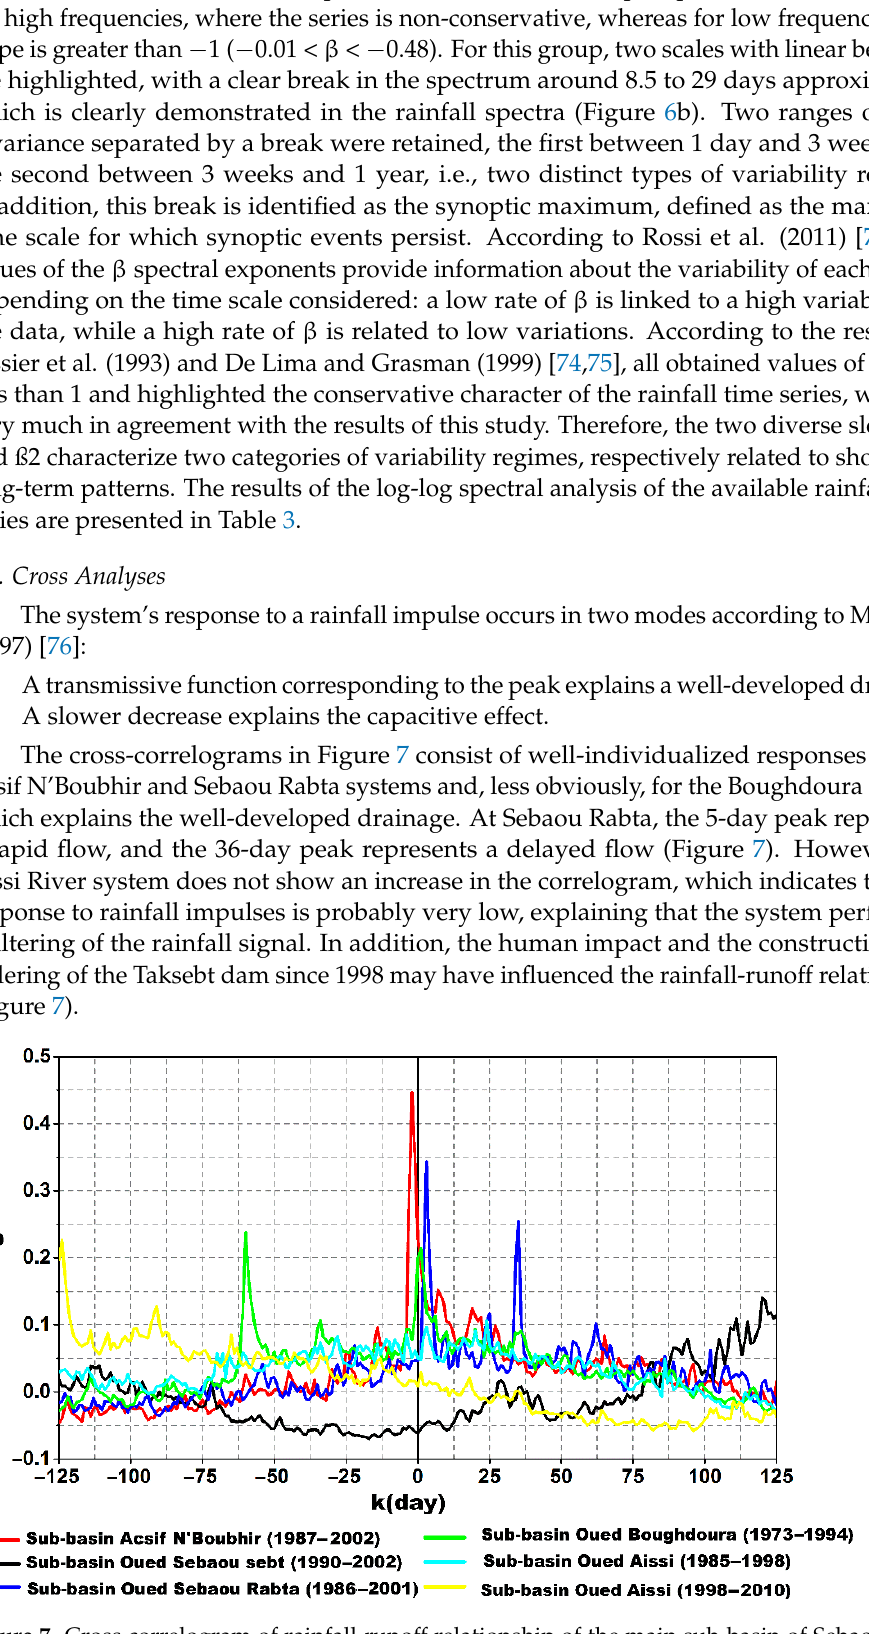
Figure 7. Cross correlogram of rainfall-runoff relationship of the main sub-basin of Sebaou River basin (windows of 125 days).